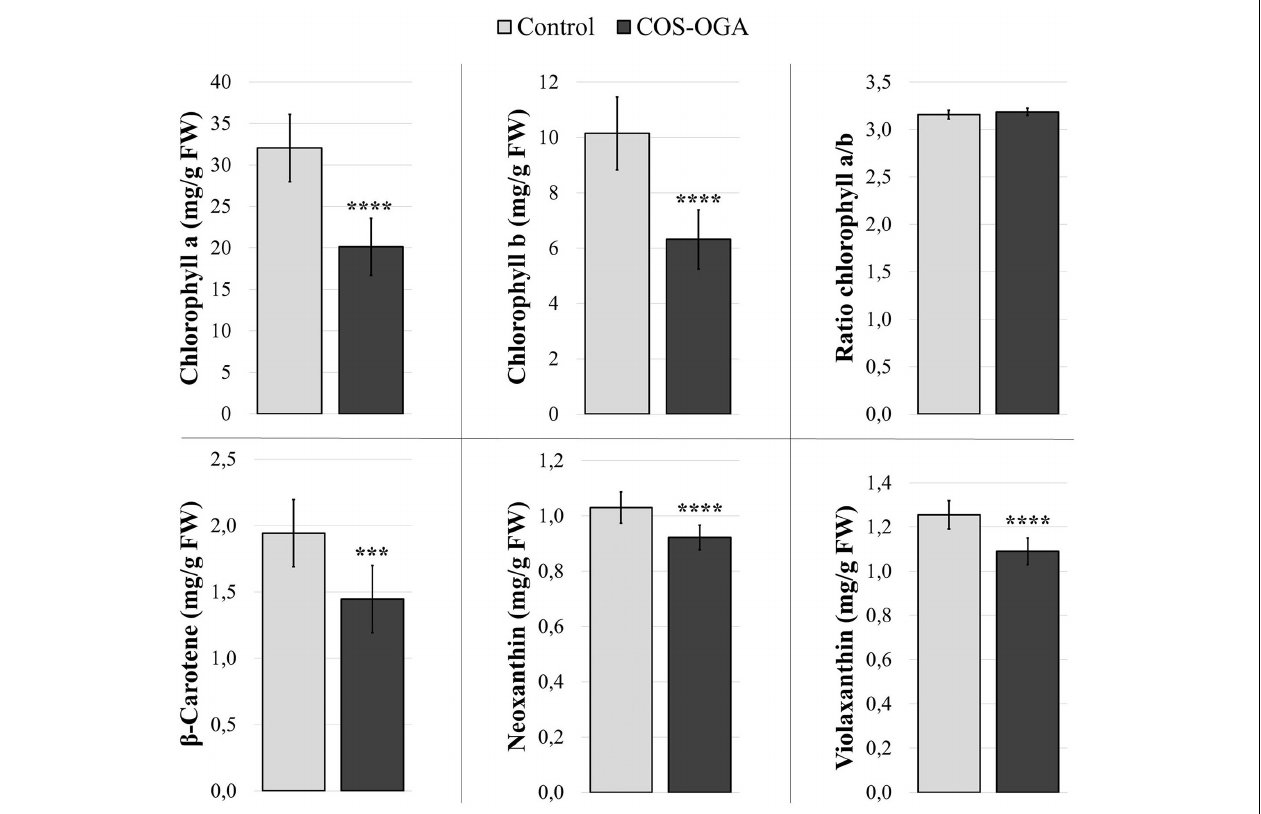
FIGURE 4 | Pigment contents of tomato leaves after three sprayings with chitooligosaccharides–oligogalacturonides (COS-OGA; 62.5 mg/l). Tomato leaves were harvested 24 h after the third treatment. The average pigment contents are expressed as mg/g fresh weigh ± standard deviation ( n = 12). *** and **** indicate statistically significant differences to the control group with p < 0.001 and p < 0.0001, respectively, (Wilcoxon test, R